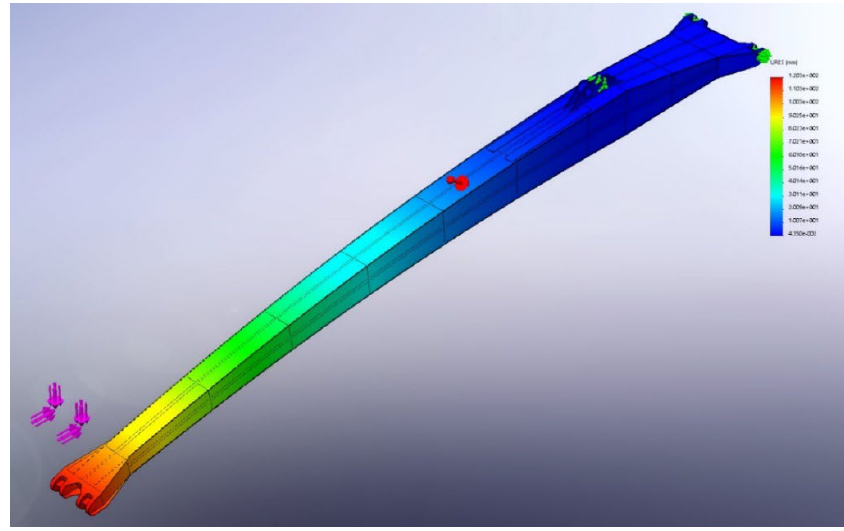
Figure 7. Deformation field.